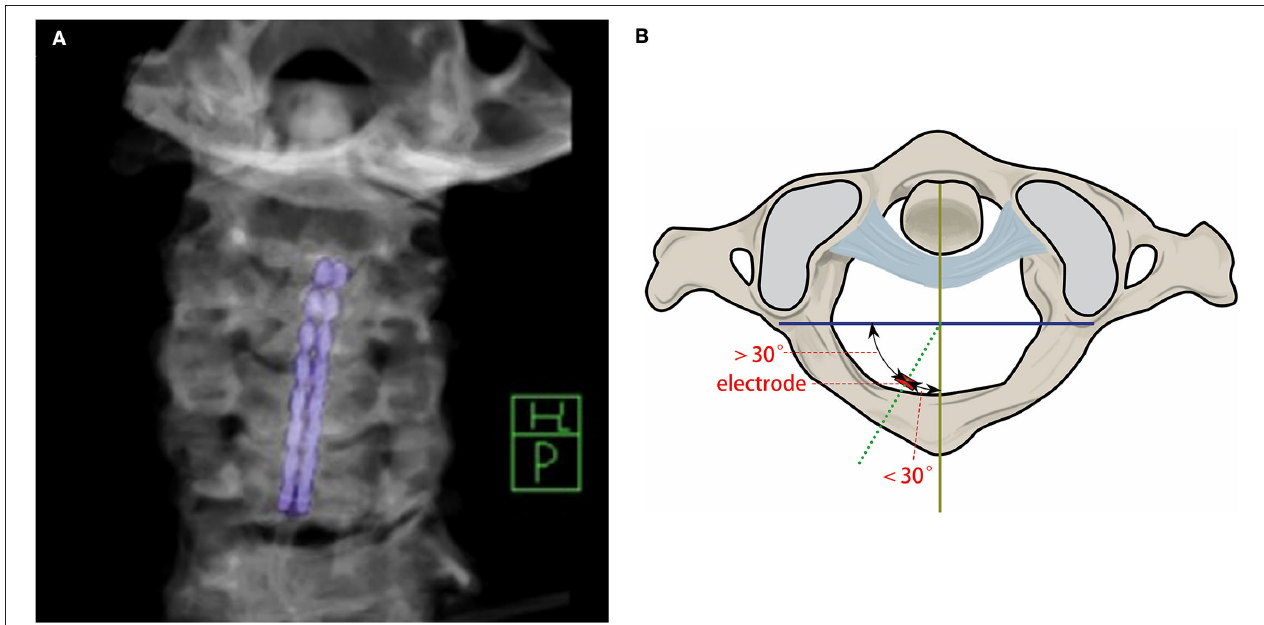
FIGURE 1 | Representative image of electrode deviation. (A) VRT reconstruction image using CT scan of the electrode and the vertical midline of the spinal canal. (B) Schematic diagram of electrode offset